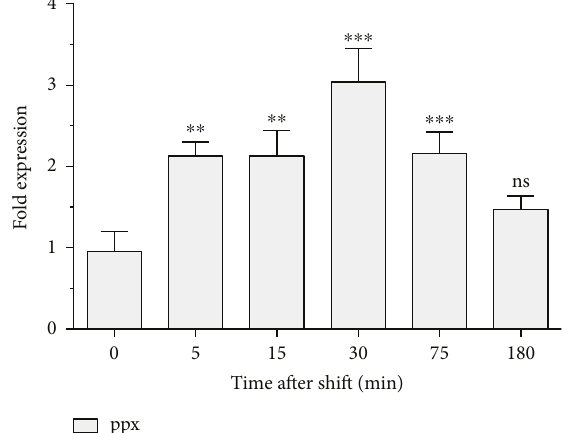
Figure 4: Transcriptional levels of ppx gene increase signi fi cantly in M. sedula DSM 5348 T cells after a copper shift. Relative transcriptional levels of ppx in M. sedula cells exposed to an 8 mM copper shift were measured by qRT-PCR. ( ∗∗ P < 0 01 ; ∗∗∗ P < 0 001 ; ns: nonsigni fi